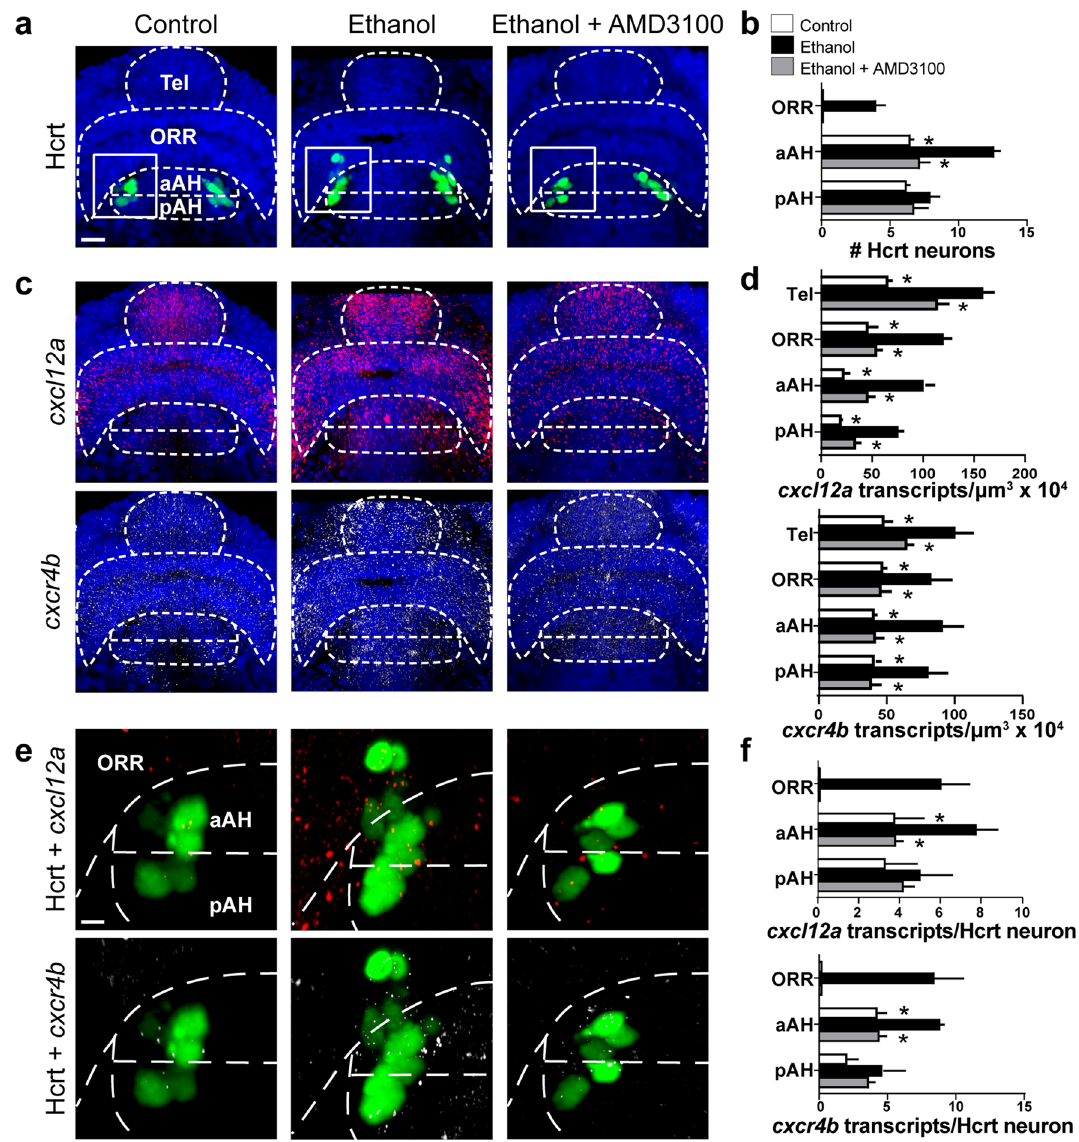
Figure 6. Effects of exposure to embryonic ethanol (0.5% v/v, 22–24 hpf) and administration of Cxcr4 antagonist AMD3100 (1 µM, 2–24 hpf) on the location of Hcrt neurons, density of cxcl12a and cxcr4b transcripts, and colocalization of cxcl12a and cxcr4b transcripts with Hcrt neurons in 28 hpf zebrafish brain. ( a ) Representative photomicrographs (×25) illustrate the zebrafish brain in a dorsal/ventral view with the pAH, aAH, ORR and Tel of the brain outlined by dashed lines and show that ethanol compared to control increases the number of Hcrt neurons (green) at 28 hpf only in the aAH and ectopically in the ORR, and these effects are completely blocked by AMD3100 as shown with cells counterstained with DAPI (blue). ( b ) Bar graphs (n = 4–5) show increased number of Hcrt neurons in the aAH of the ethanol group relative to the control and ethanol + AMD3100 groups, with no effect of ethanol on Hcrt number in the pAH. Ethanol-induced Hcrt neurons in the ORR are evident only in the ethanol group ( c ) Representative photomicrographs show the density of internalized cxcl12a (red, top) and cxcr4b (white, bottom) transcripts to be increased throughout the brain in the ethanol group compared to the control and ethanol + AMD3100 groups. ( d ) Bar graphs (n = 4–5) show increased density of the cxcl12a (top) and cxcr4b (bottom) transcripts in all brain regions, including the pAH, aAH, ORR and Tel, in the ethanol group compared to the control and ethanol + AMD3100 groups. ( e ) Enlargement of boxes at 28 hpf show the Hcrt neurons, located in the aAH and ectopically in the ORR but not the pAH, co-localize with a greater number of both cxcl12a (top) and cxcr4b (bottom) transcripts in the ethanol group compared to the control and ethanol + AMD3100 groups. ( f ) Bar graphs (n = 4–5) show an increased number of cxcl12a (top) and cxcr4b (bottom) transcripts in Hcrt neurons in the aAH of the ethanol group compared to the control and ethanol + AMD3100 groups, with no change between groups occurring in the pAH. Ectopically located Hcrt neurons in the ORR seen only in the ethanol group show similar levels of co-localization as evident in Hcrt neurons of the aAH. Scale bar low magnification 20 µm; high magnification 8 µm. * p < 0.05 compared to ethanol. Results are shown as means ± standard errors. AH anterior hypothalamus, aAH anterior part of the anterior hypothalamus, pAH posterior part of the anterior hypothalamus, ORR optic recess region, Tel Telencephalon, Hcrt Hypocretin, hpf hours post